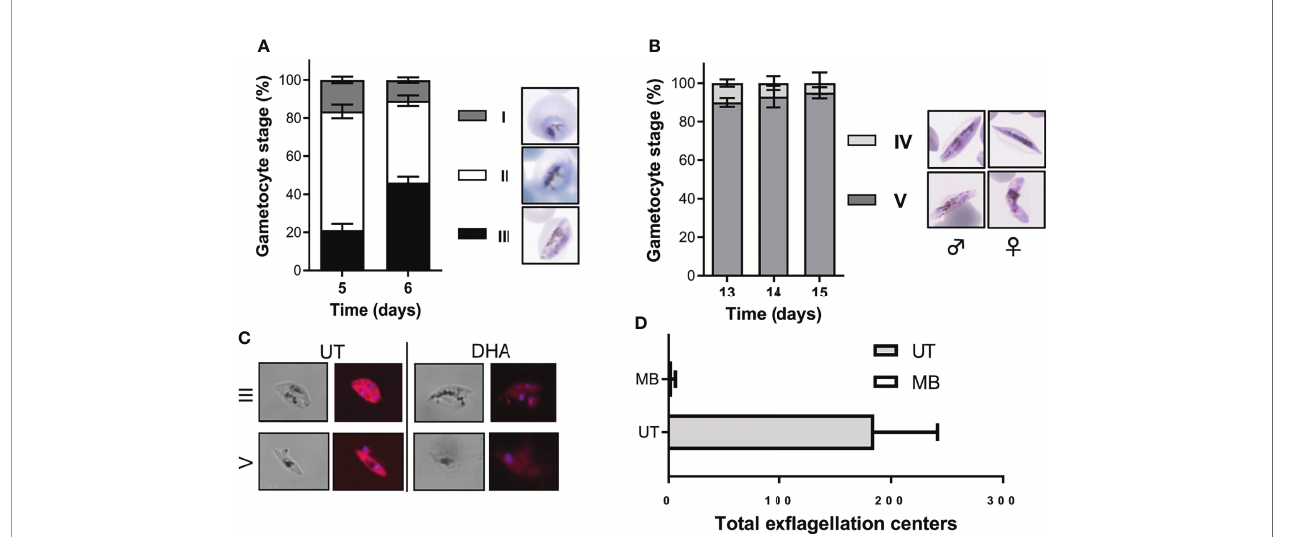
FIGURE 2 | Morphological stage distribution and viability con fi rmation of immature and mature gametocytes. Quanti fi cation of the stage distribution of (A) immature gametocytes indicated at >80% enrichment to stage II/III gametocytes and (B) >90% stage V mature gametocytes on the day of assay. N > 30 individual exp, ~500 red blood cell counted/exp ± S.E. (C) Hydroethidine-stained confocal images con fi rmed the viability of untreated gametocytes and the “ dead ” phenotype observed following DHA treatment on both immature and mature gametocytes (at 1× IC 50 of 20 nM and 5 µM, respectively). Magni fi cation, ×1,000. (D) Viability of mature gametocytes was further evaluated by con fi rming male ex fl agellation before initiating any assays (N > 25, ± S.E.). MB, methylene blue (10 µM) treated gametocytes; UT, untreated